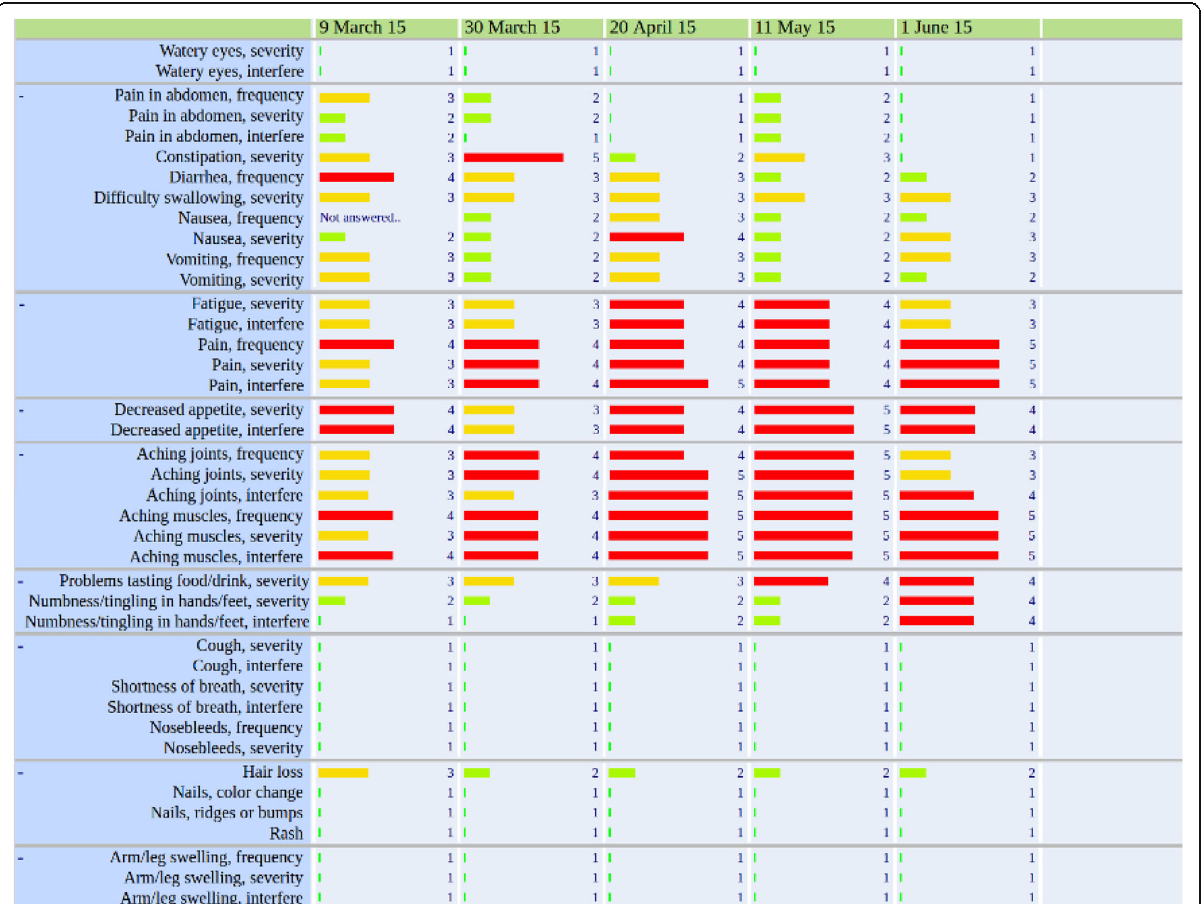
Fig. 2 Overview of patients ’ reporting available at the oncologists ’ computers in real-time. Items are presented as bars with different colors (for example, red = very severe, orange = severe, yellow = moderate, light green = mild, dark green = none), lengths and numbers (1 – 5) for each date of treatment visit. Note: In our study, the symptomatic toxicities were in Danish language, but are here presented in